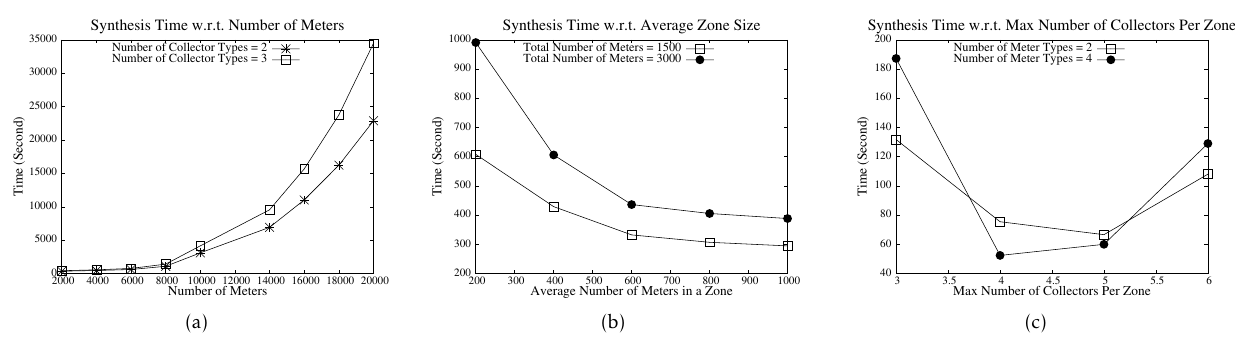
Figure 4. The execution of the synthesis framework with respect to (a) the number of meters, (b) the average size of each zone, and (c) the maximum number of collectors per